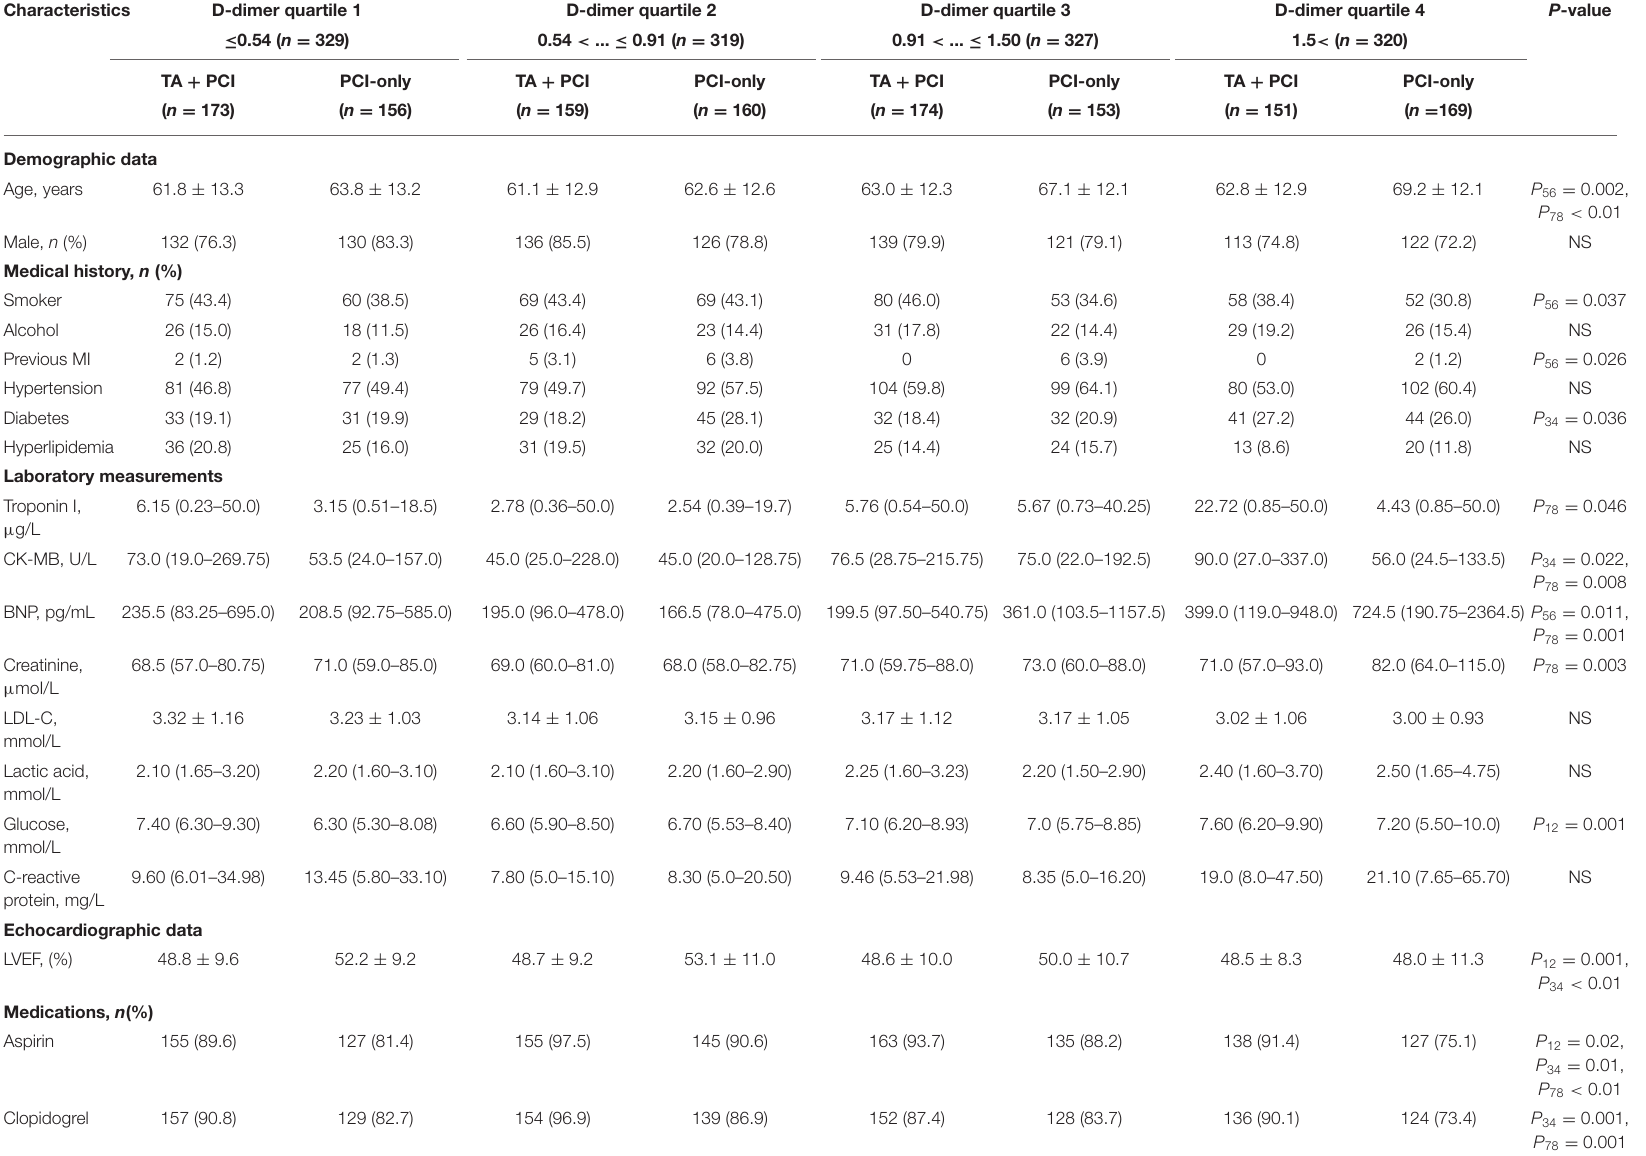
TABLE 2 | Baseline characteristics according to plasma D-dimer concentrations and treatment